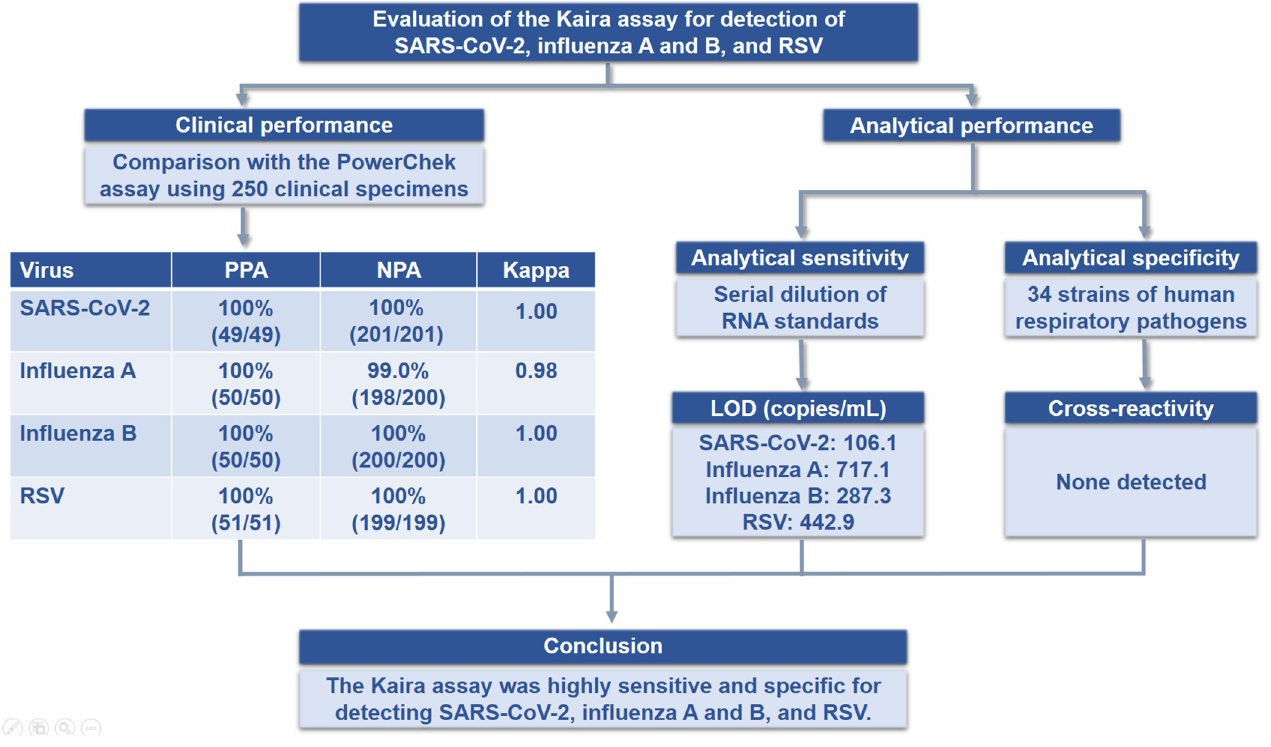
Fig 1. Graphical abstract of the study.